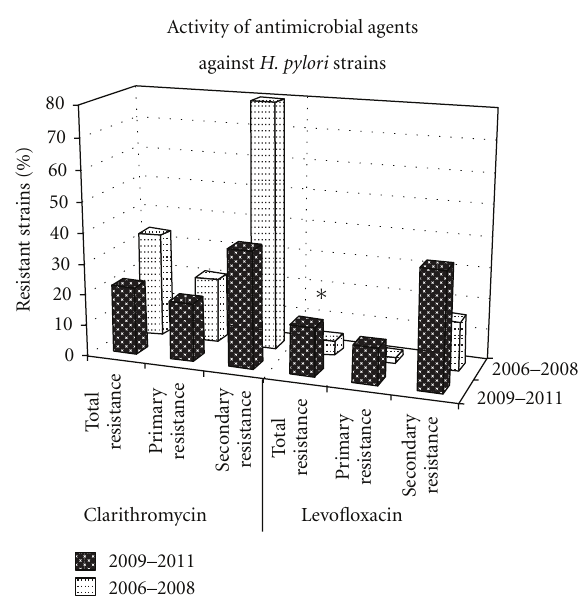
Figure 3: Activity of clarithromycin and levofloxacin against pri- mary and secondary H. pylori strains. ∗ statistically significant dif- ferences between the level of resistance to levofloxacin in the